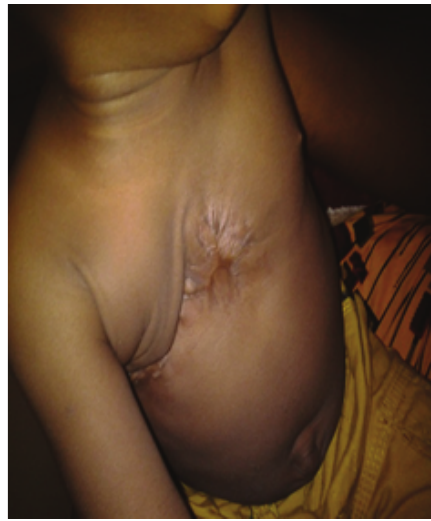
Figure 2: 10 months after